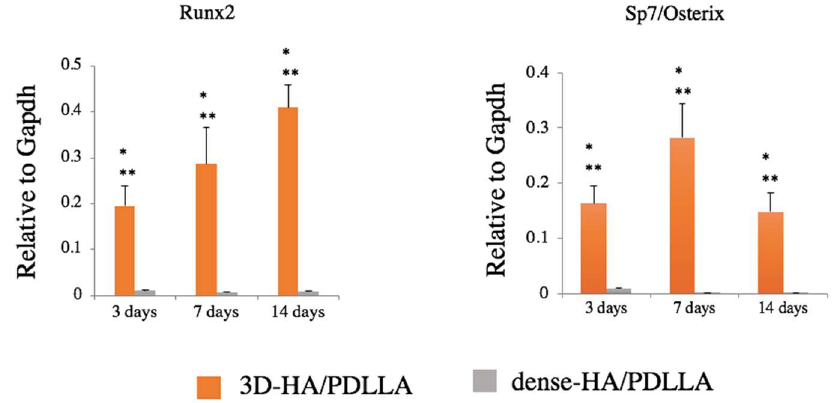
Figure 3. Gene expression of osteogenic markers Runx2 and Sp7/Osterix. Expression was significantly higher in the 3D-HA/PDLLA group (one-factor ANOVA test, * p < 0.0001; Tukey–Kramer test, ** p < 0.01). n = 3 per group. Error bars represent the standard deviation.